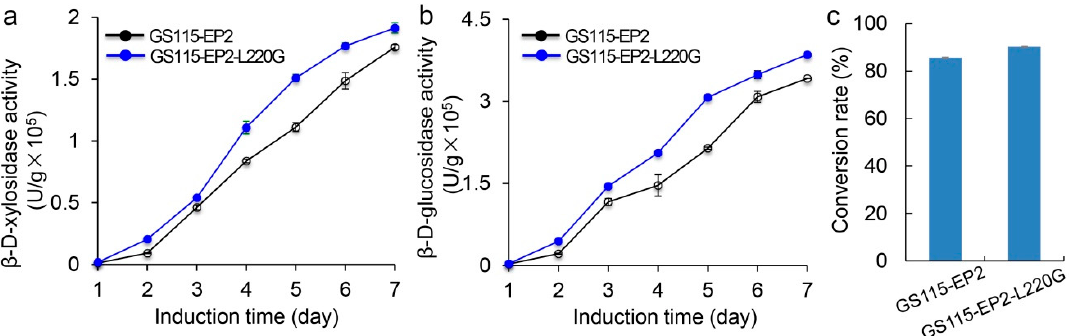
Figure 3. The β -D-xylosidase activities ( a ), β -D-glucosidase activities ( b ), and conversion rates towards XDT ( c ) of the Figure 3. The β - D -xylosidase activities ( a ), β - D -glucosidase activities ( b ), and conversion rates towards XDT ( c ) of the recombinant yeasts GS115-EP2 and GS115-EP2-L220G. Data are the mean ± SD, n = 3. recombinant yeasts GS115-EP2 and GS115-EP2-L220G. Data are the mean ± SD, n =